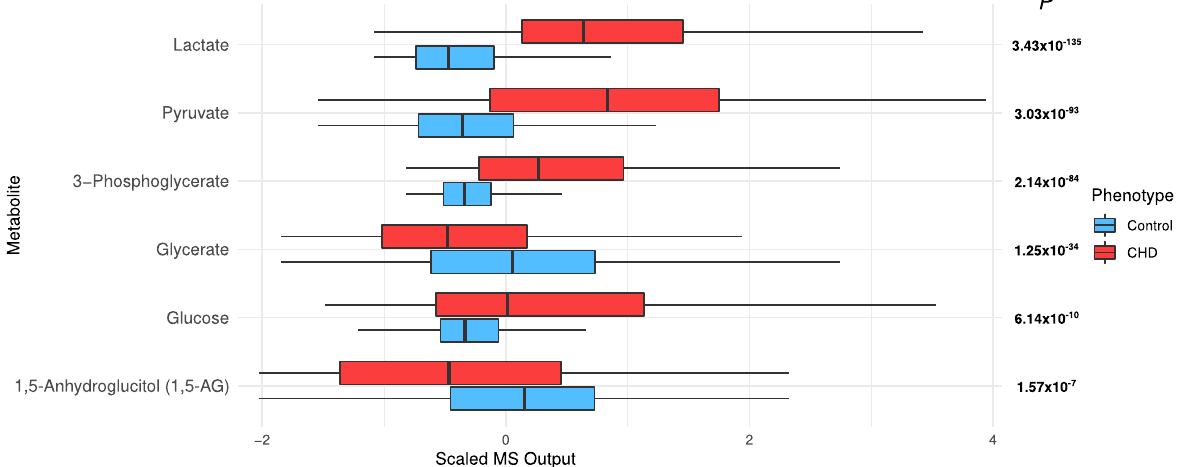
Figure 7. The distribution of sugars in the CHD patients and the